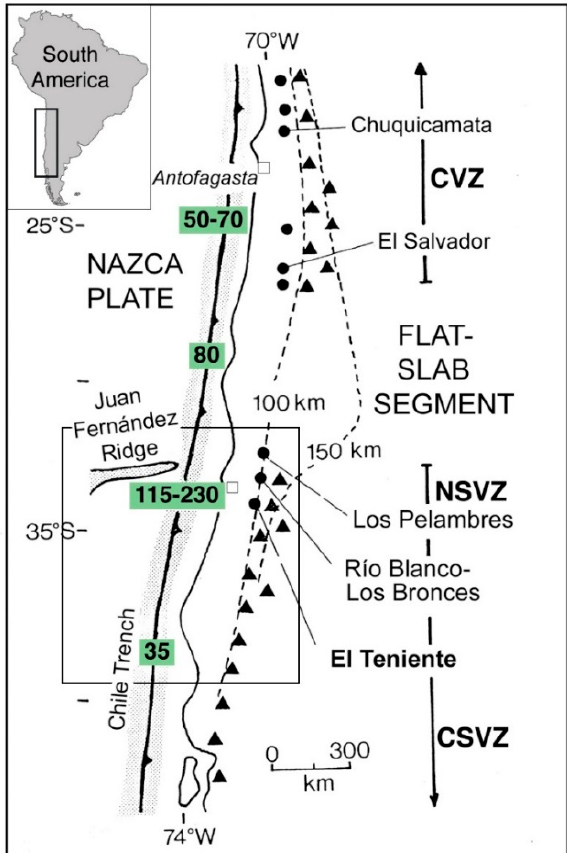
Figure 2. Location map of El Teniente, the two other giant Late Miocene Cu-Mo deposits, Los Pelambres and Río Blanco-Los Bronces, in the Andes of central Chile, and some of the other giant Late Eocene and Early Oligocene Cu-Mo deposits in northern Chile west of the Andean Central Volcanic Zone (CVZ). The area of the figure is indicated by the box in the inset, and the box in the figure shows the region illustrated in Figure 3. The figure also shows tectonic features such as the Chile Trench, which is the boundary between the Nazca and South American plates, and the depth in kilometers (100 and 150 km dashed lines) to the Benioff Zone below South America. The locus of subduction of the Juan Fernández Ridge occurs at the boundary between the Andean Flat-Slab segment, below which the subduction angle is very low as indicated by the depths to the upper boundary of the subducted slab, and the northern and central parts of the Andean Southern Volcanic Zone (NSVZ and CSVZ) of active volcanoes, below which subduction angle is steeper. The numbers in the green boxes are the estimated rates of subduction erosion in km 3 /km/m.y. in each region [5] . Subduction erosion rates are higher in northern compared to south-central Chile because of the arid conditions in the north, resulting in a trench devoid of sediment, and humid conditions in the south, resulting in a trench filled with sediment [4,5,9]. Rates are highest just south of the locus of subduction of the Juan Fernández Ridge due to the effects of the subduction of this buoyant feature [5,26,27]. (Reprinted from Geology, volume 22, Skewes, M.A. and Stern, C.R. Tectonic trigger for the formation of late Miocene Cu-rich breccia pipes in the Andes of central Chile, page 552, Copyright 1994, with fair use permission from the Geologic Society of America.).